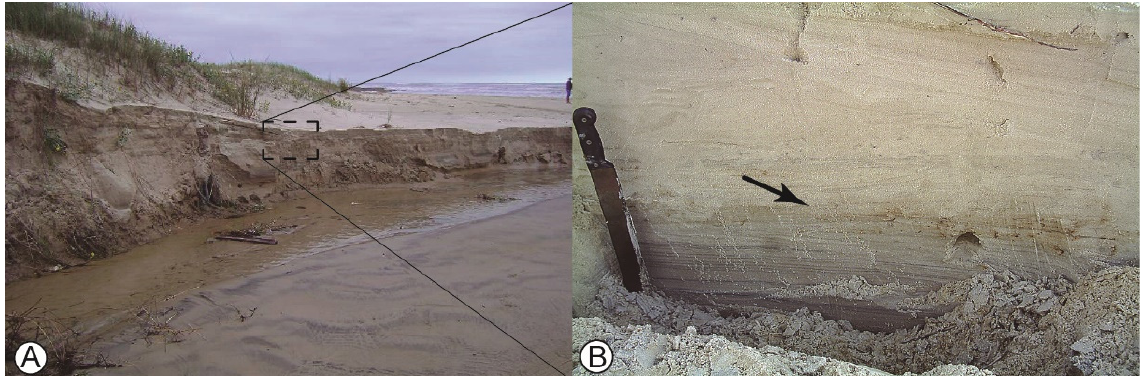
Figure 4. ( A ) The morphological transition between the foredune and the backshore at the Curumim barrier and ( B ) detail of the sharp contact (black arrow) between backshore sands (light grey color) and foredune sands (white to pale yellow). At this place the contact is located 1.5 m above mean sea level (picture orientation is NW-SE).